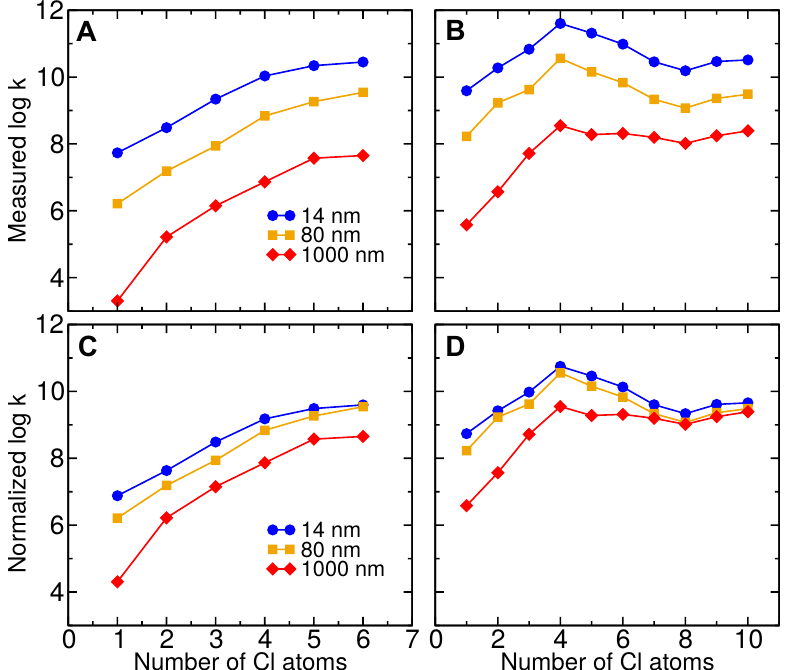
Figure 7. Effect of the ZnO particle size on adsorption coefficients of aromatic organochlorines. Adsorption coefficients for chlorobenzene ( A ) or PCB ( B ) adsorption on ZnO particles with average diameters of 14, 80, 1000 nm. Adsorption coefficients for adsorption of chlorobenzenes ( C ) or PCBs ( D ) normalized to represent 80 nm particles assuming a spherical